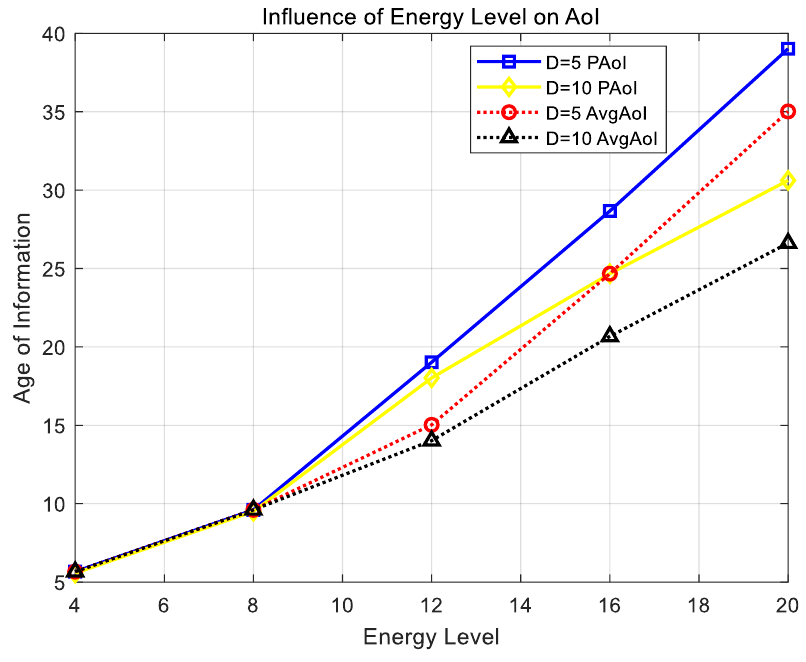
Figure 4. Influence of Energy Level on AoI.